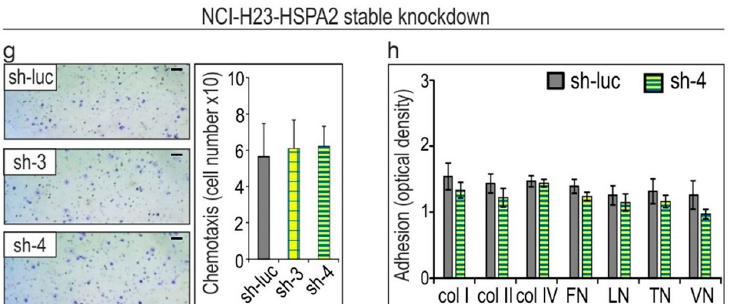
Figure 5. HSPA2 knockdown has no e ff ects on the motility, invasiveness, and adhesion of ( a – d ) NCI-H1299 cells; ( e , f ) NCI-H358 cells; and ( g , h ) NCI-H23 cells. ( a , e ) Results of the wound-healing assay. The microphotographs of a wound area were taken immediately after making a scratch in confluent cell culture (0 h) and after subsequent culture for 16 h (NCI-H1299) or 24–48 h (NCI-H358). Arrows mark the wound width. The graphs show mean ± SD ( n = 4 in ( a ); n = 3 in ( e ); each at least in ten technical replicas). ( b , g ) Results of chemotactic migration assay. Cells (5 × 10 4 ) were plated onto an insert and allowed to migrate for 6 h toward the FBS gradient (1–10%). Representative microphotographs show crystal violet-stained cells that migrated through the membrane pores. The graphs show mean ± SD ( n = 5). ( c ) Results of cell invasion assay. Representative microphotographs show crystal violet-stained cells that migrated into Matrigel. The scale bar represents 50 µ m. The graph shows the percent of invading cells (mean ± SD, n = 4, cells were counted in six di ff erent areas). ( d , f , h ) Results of adhesion assay. NCI-H1299 (6 × 10 4 / well), NCI-H358 (7 × 10 4 / well), and NCI-H23 (7 × 10 4 / well) cells were plated onto the ECM Cell Adhesion Array strips and allowed to attach for 1 to the ECM components: col, collagen; FN, fibronectin; LN, laminin; TN, tenascin; VN, vitronectin. Results show mean ± SD ( n = 2, each in two technical replicas).